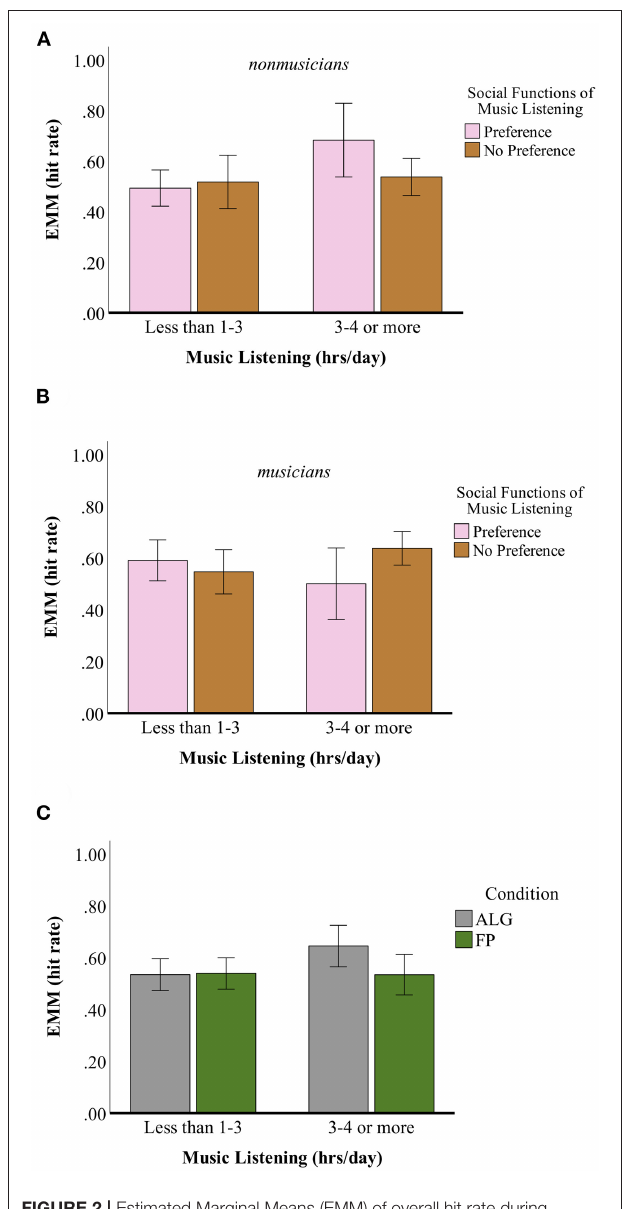
FIGURE 2 | Estimated Marginal Means (EMM) of overall hit rate during recognition task (hit rate) for between-subject effects of mus_back * hrs_list * mus_soc1 , with (A) vs. (B) panels showing EMMs for non-musicians vs. musicians ( mus_back = 0 vs. mus_back = 1 ); pink bars denoting EMMs for participants with scores < = 3 for preference for social functions of music listening item, brown bars for scores of > 3 ( mus_soc1 ); and x-axis separating EMMs for participants who reported either listening to ≤ 1–3 or ≥ 3–4h of music per day (C) cond * hrs_list, with gray bars denoting EMMs for participants in the ALG experimental condition and green bars in the FP condition. For each panel, Error Bars correspond to 95% confidence